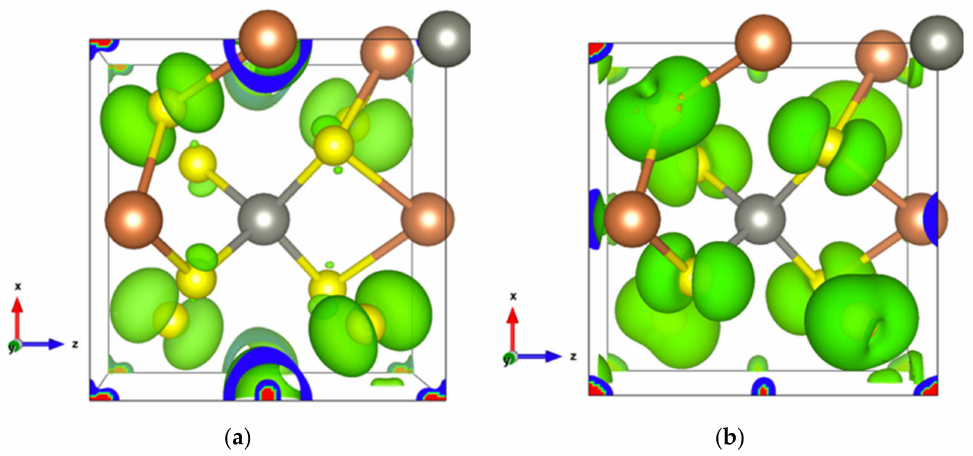
Figure 12. Electron density of SbS 2 Zn 2 ( a ) In the highest occupied orbital; ( b ) In the energy range comprising the top two valence orbitals with an isosurface of 0.002 electrons / bohr 3 . Regarding the thermoelectric e ff ect, the very low density of states at the valence band edge (Figure S13b) results in a Seebeck coe ffi cient for hole doping lower than that for electron